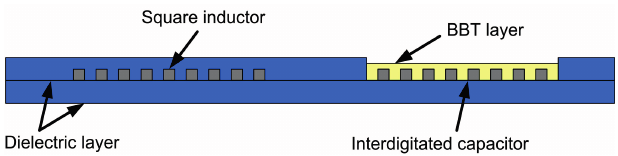
Figure 1. The inductive-capacitive (LC) sensor cross section.